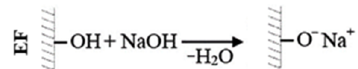
Figure 1. Alkali treatment of eucalyptus fibers.